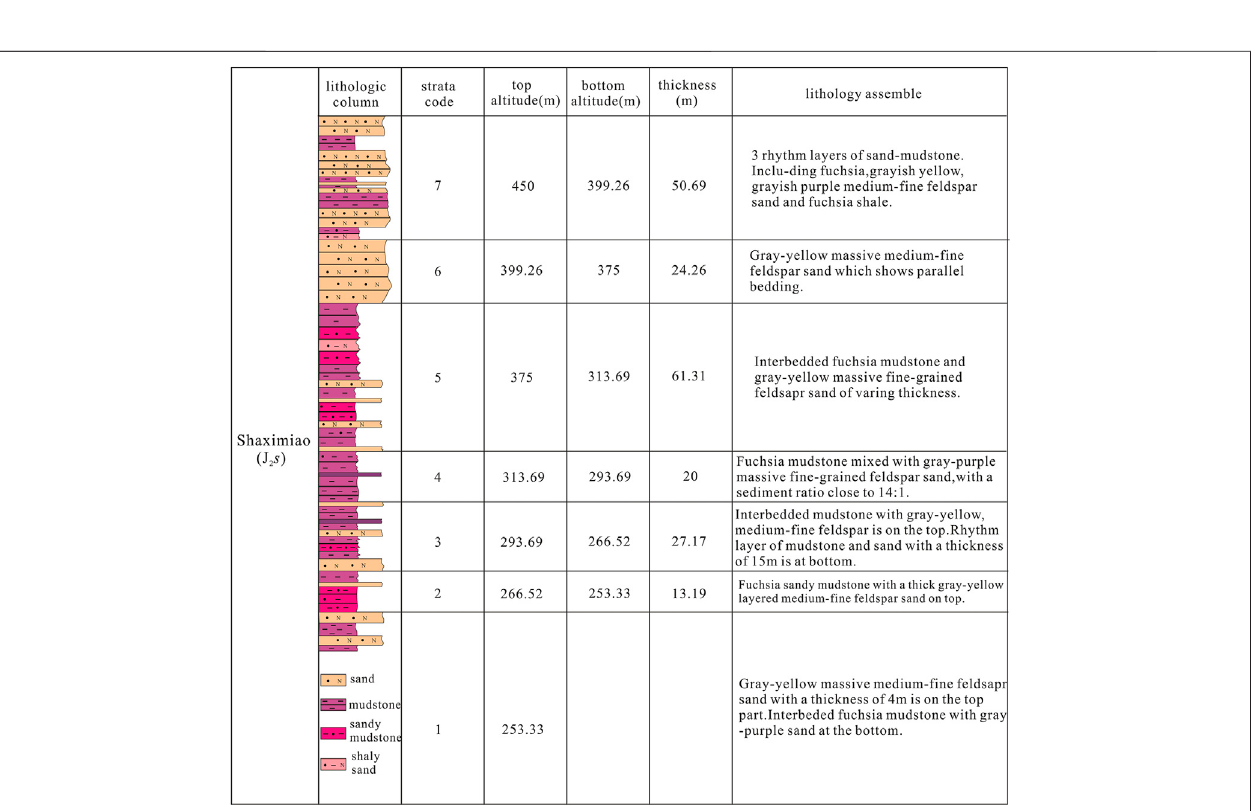
FIGURE 5 | Geotechnical unit classi fi cation of the Shaximiao Formation (J 2 s) in the study area.